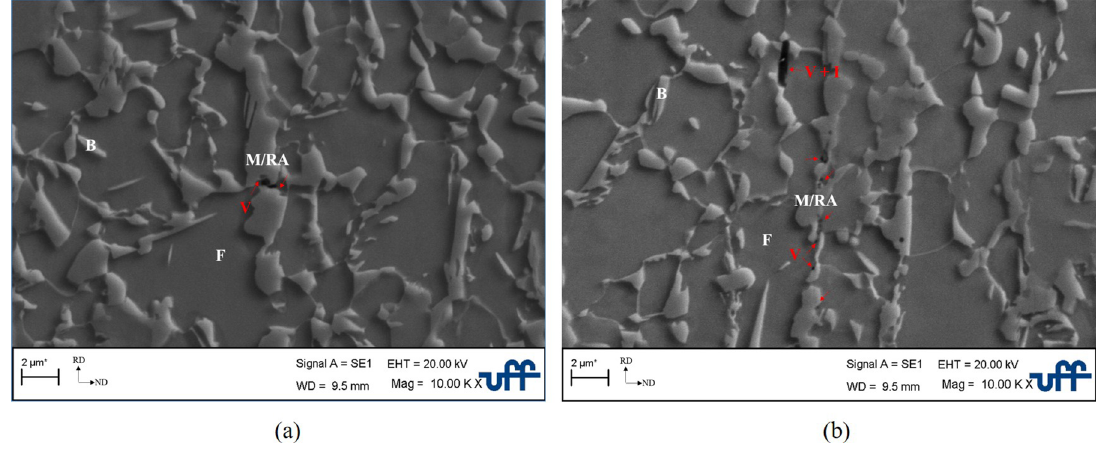
Figure 8. Scanning electron microscopy images obtained from the TRIP780 steel sheet uniaxial samples deformed at (a) 5% (10000×) and (b) 10% (10000×) of total strain. The micrographs were taken at regions cut parallel to the sheet rolling direction, i.e., along the major strain axis. The letters B, F, M/RA, V and I designate ferrite, martensite/retained austenite, void and inclusion, respectively.